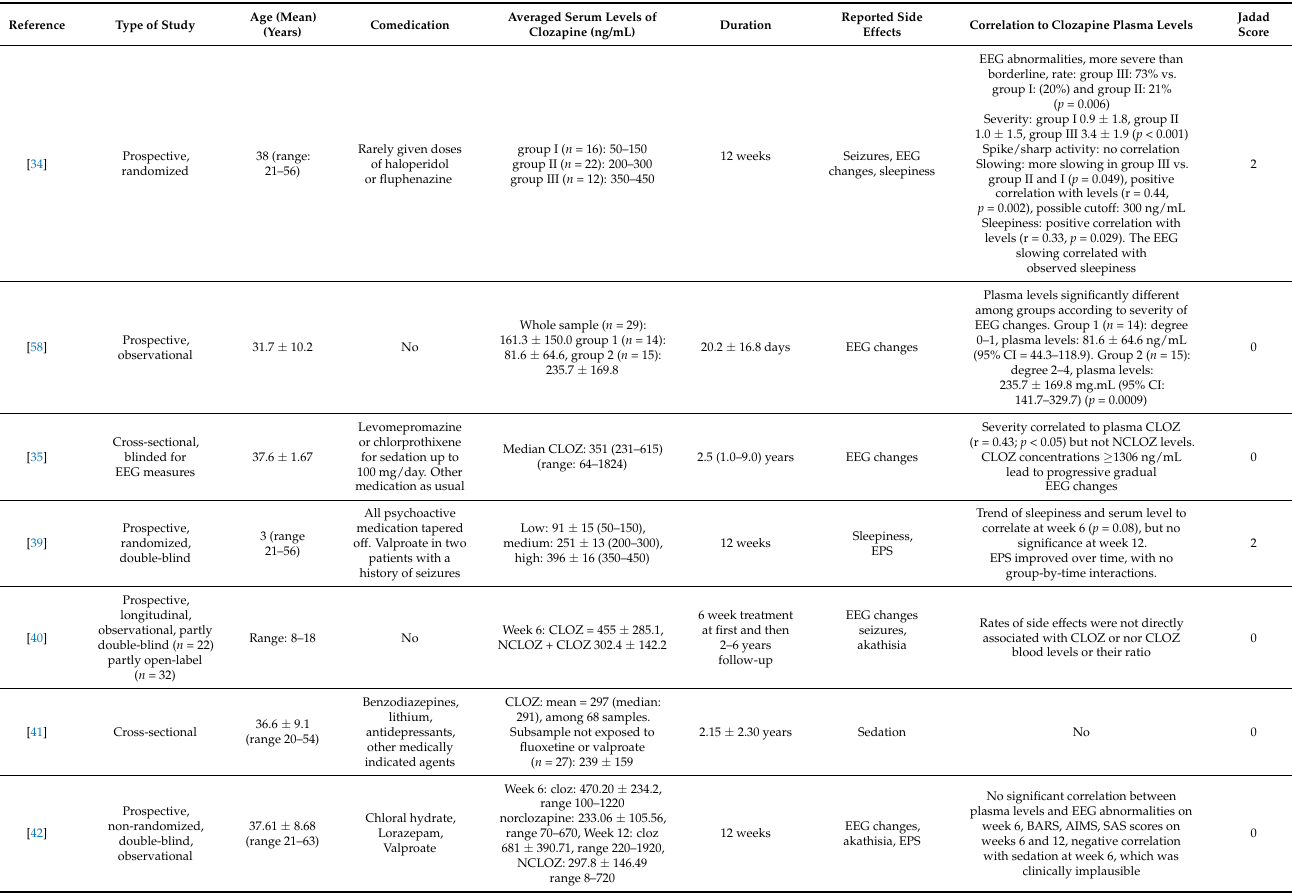
Table 3. Nervous system and psychiatric adverse effects in relation to CLOZ plasma